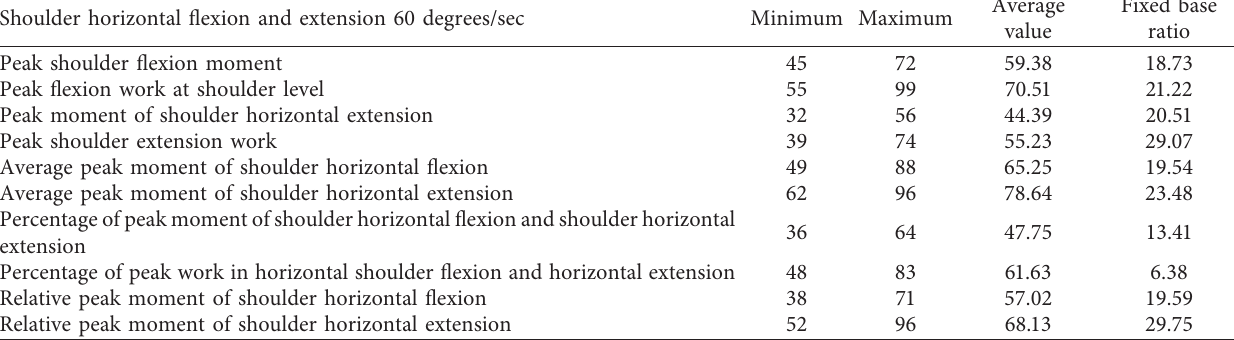
Percentage of peak moment of shoulder horizontal flexion and shoulder horizontal